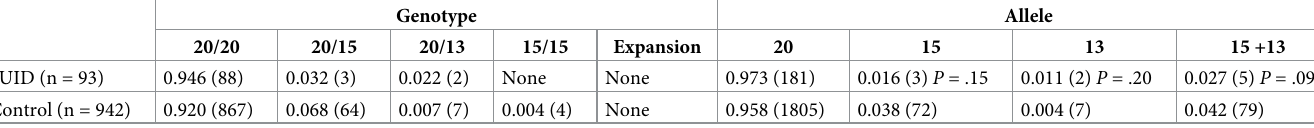
Table 1. Frequency (number) of genotypes and alleles of the polyalanine repeat in the SUID and control